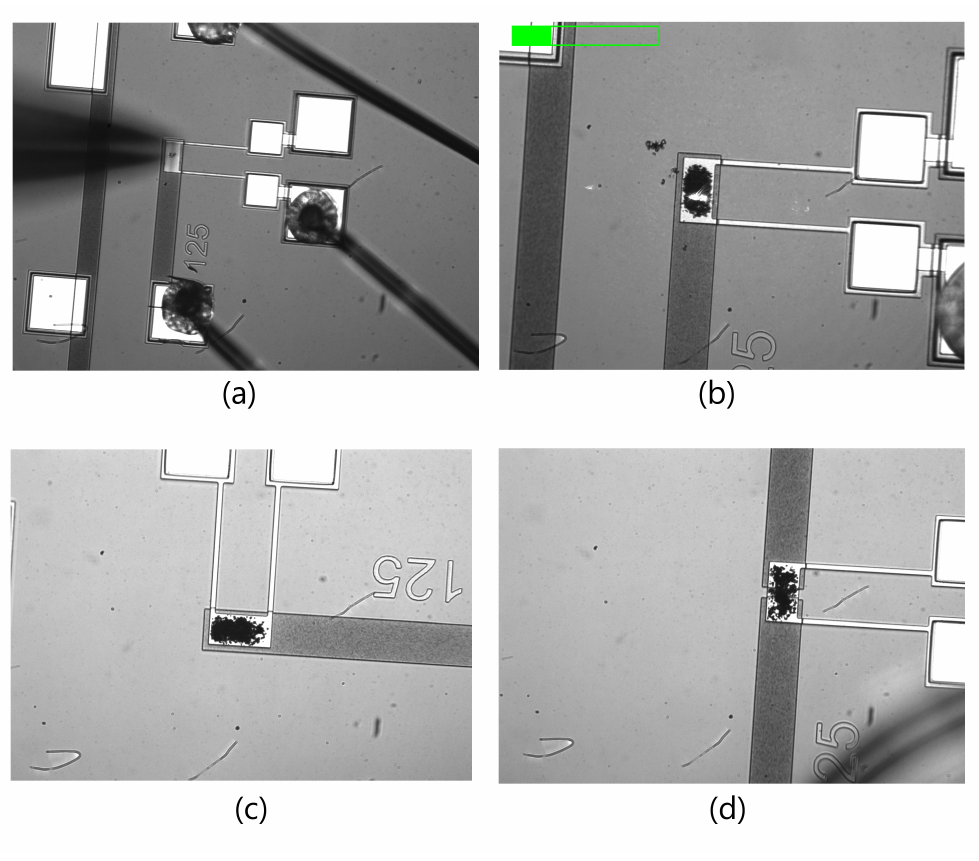
Figure 10. ( a ) The polymer depositing process on the sensor and ( b – d ) functionalized